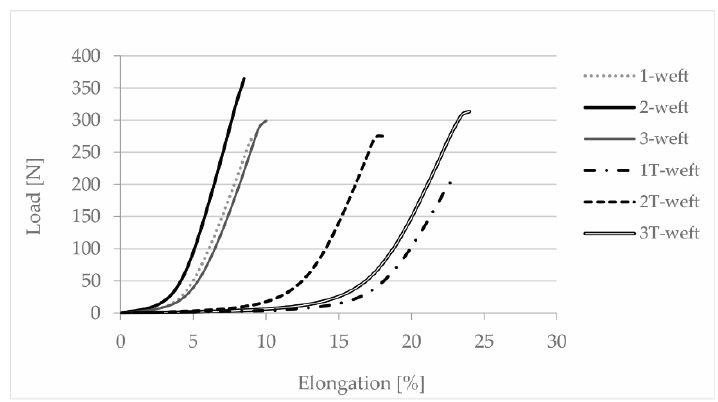
Figure 7. Load/elongation curves of woven samples in weft direction before and after treatment.